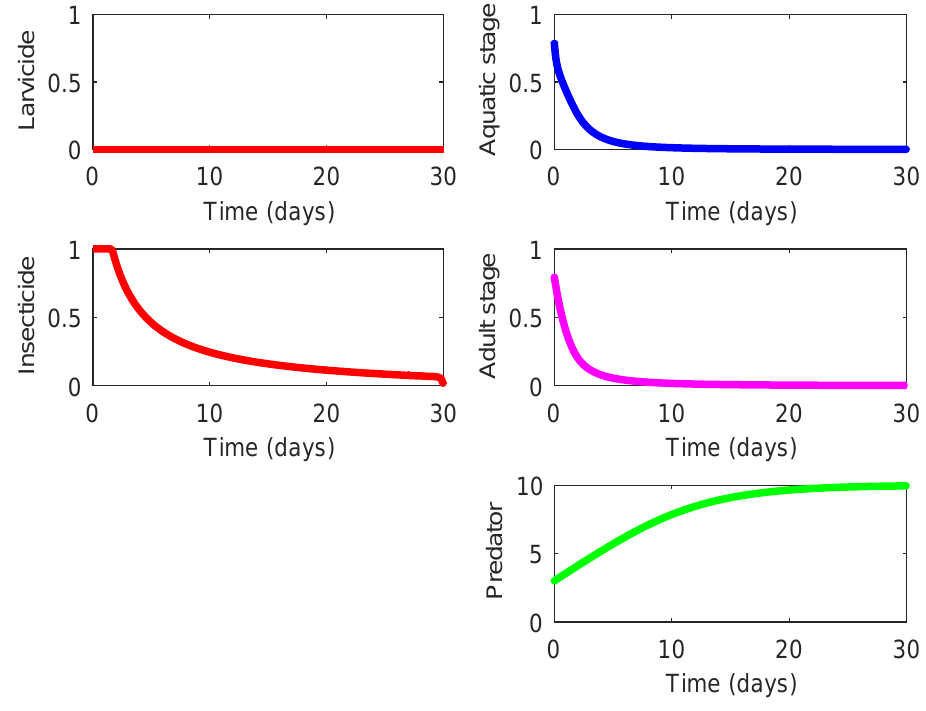
Figure 5. State and control profiles of the system (1) under Strategy 220: presence of efficient predator combined with application of high-lethality